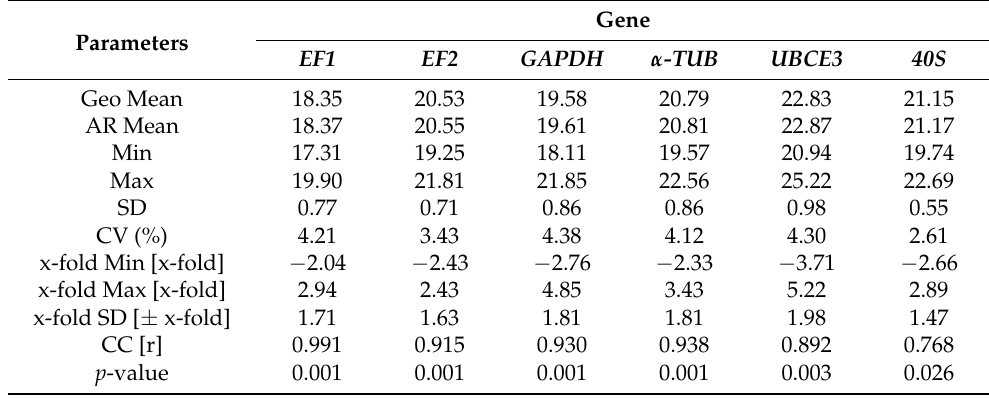
Figure 2. The stability analysis of candidate reference genes. ( A ): Ranking by the △ Ct method; the graph shows the standard deviation of average expression value for the candidate reference genes; ( B ): Ranking by the NormFinder algorithm; the graph shows the stability value for the candidate reference genes; ( C ): Ranking by the geNorm algorithm; the graph shows the stability value for the candidate reference genes; ( D ): Ranking by the RefFinder; the graph shows the comprehensive stability values for the candidate reference genes. Genes represented on the abscissa from left to right means the least stable to the most stable. Table 2. Expression stability of the candidate reference genes evaluated by BestKeeper.